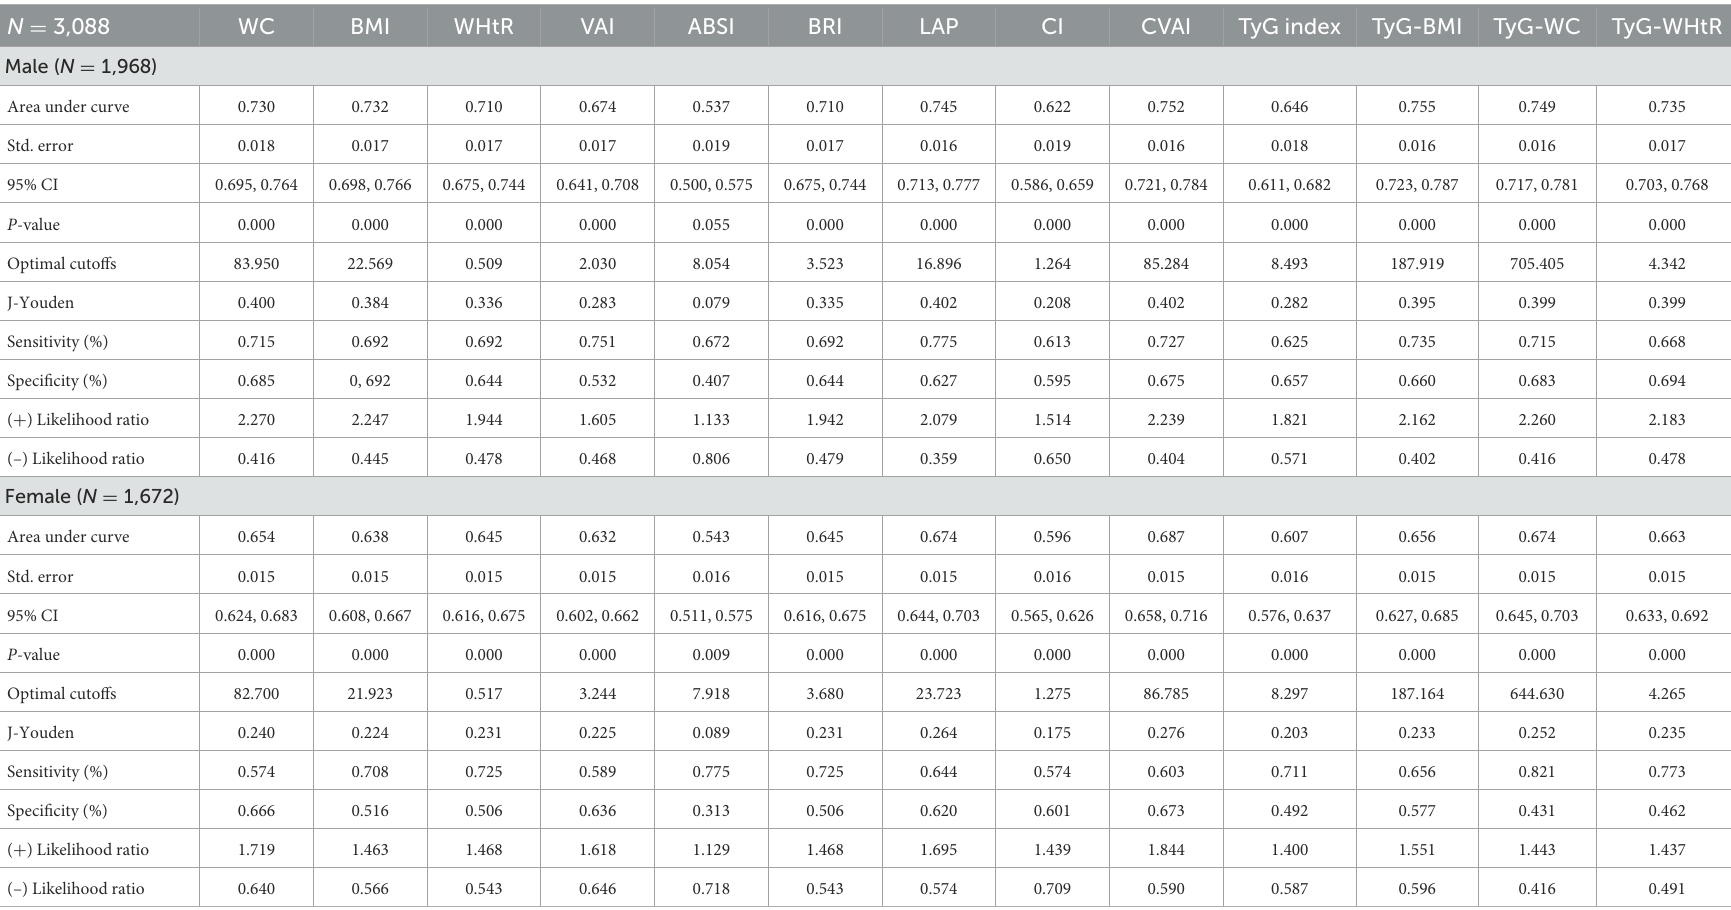
TABLE 3 Cutoff value between area under curve, sensitivity, and specificity for obesity- and lipid-related indices to detect metabolic syndrome (CHARLS2011–2015) by sex. N =